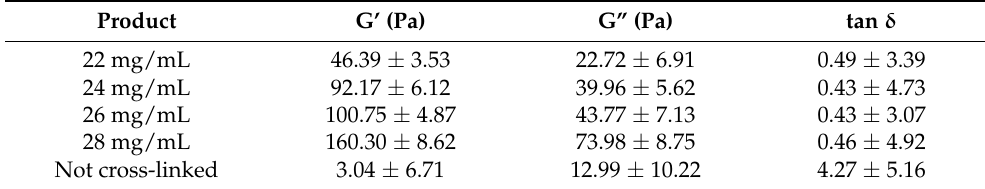
Table 4. Rheological data obtained by the characterization of the five tested HA hydrogels at 25 ◦ C and at a frequency value of 1 Hz. Data are represented as averages and relative standard deviation percentage (RSD